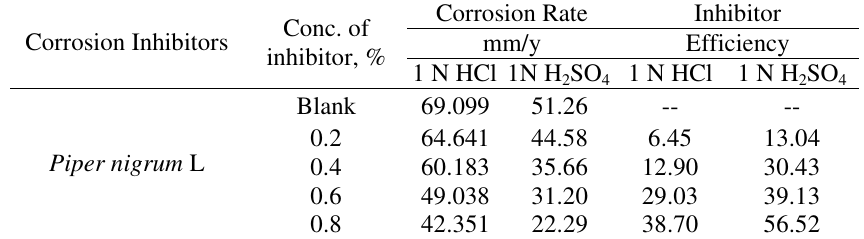
Table 1. The values of corrosion rate and inhibition efficiency of mild steel in 1 N HCl and 1N H SO solution in absence and presence of Piper nigrum L 2 4